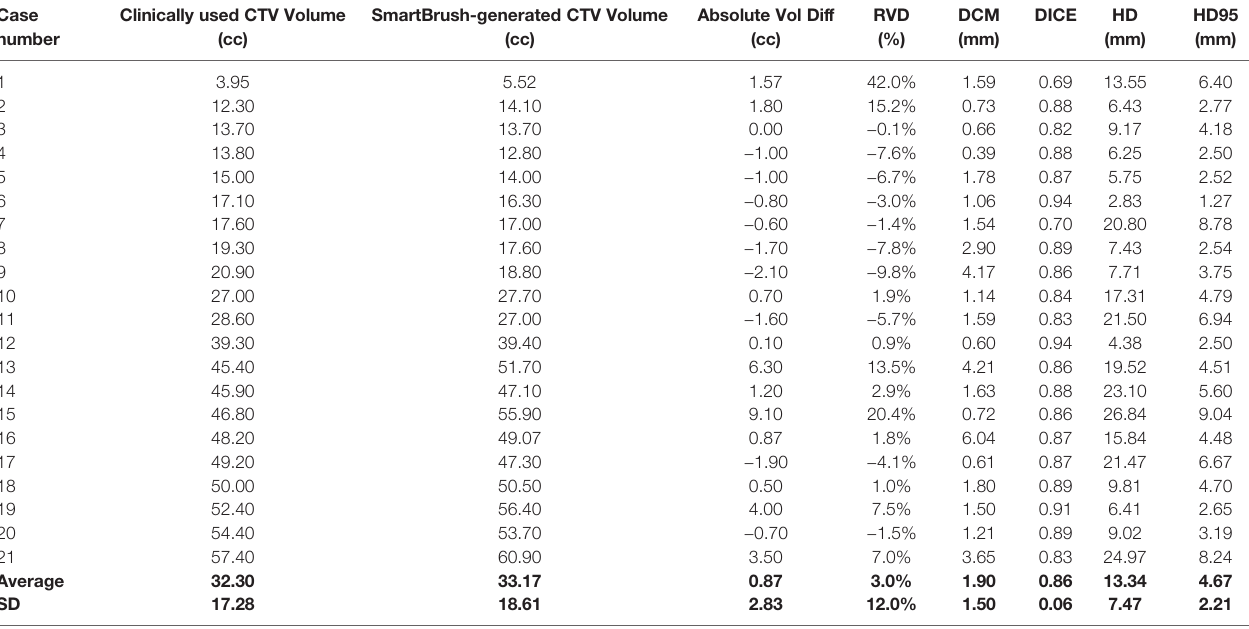
The bold values are Average and SD to distinguish from values of each